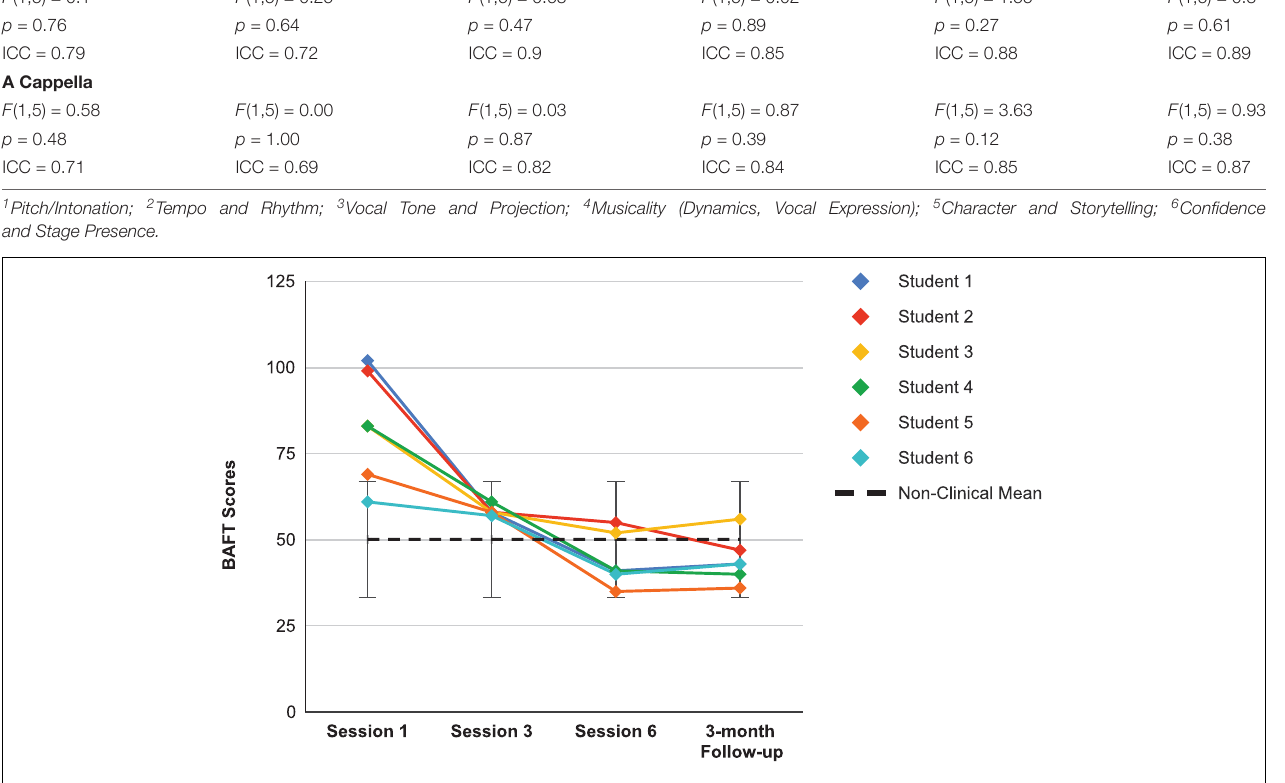
FIGURE 2 | Believability in Anxious Feelings and Thoughts scores for the current students, from pre-coaching (Session 1), midway (Session 3), post-coaching (Session 6), and the 3-month follow-up, with the non-clinical mean (50.10) and bars spanning one standard deviation up/down ( SD = 16.88; Herzberg et al.,